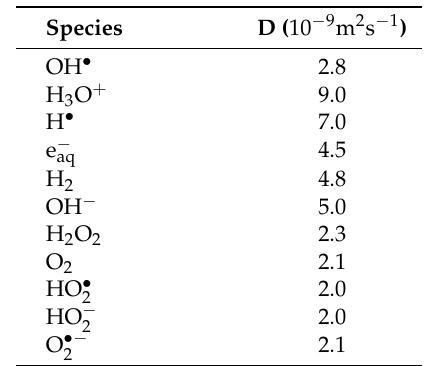
Table 2. List of all the chemical species and their diffusion coefficients, D , added to the chemical species list of TRAX to describe the impact of dissolved molecular oxygen in the water